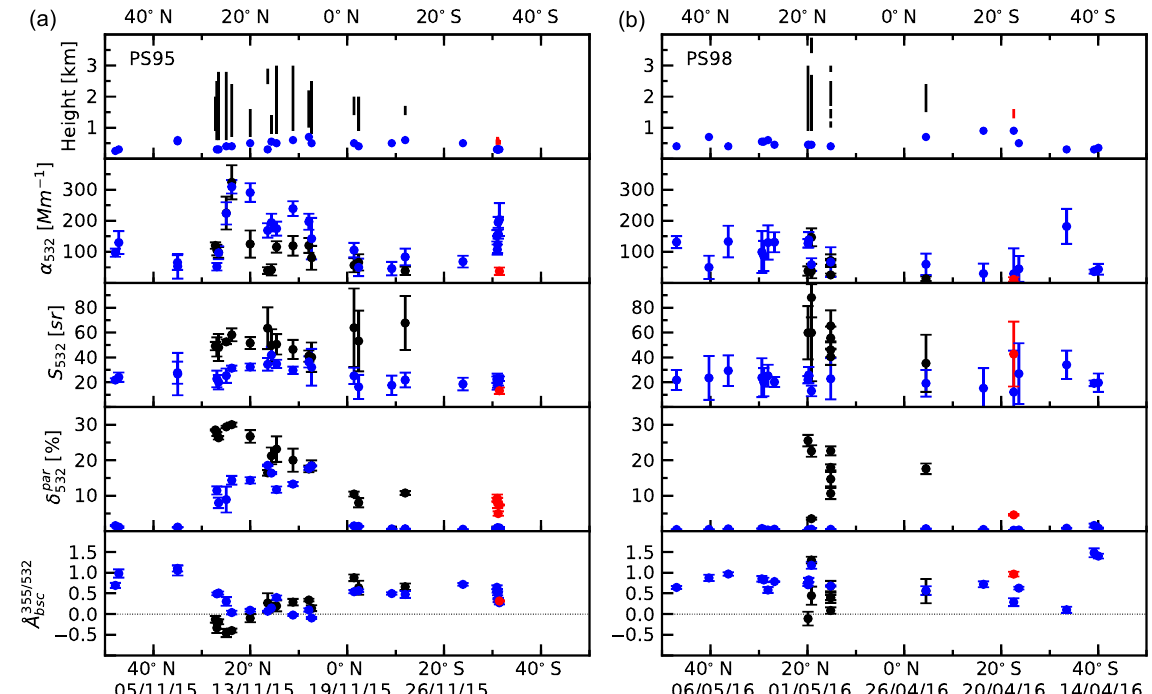
Figure 13. Mean values of extinction coefficient, lidar ratio and particle depolarisation ratio at 532nm, and the backscatter-related Ångström exponent at 355/532nm (top down) for MBL (blue), elevated aerosol layers (black), and dried marine layers (red) on PS95 (a) and PS98 (b) from north to south. Error bars indicate the standard deviation. MBL top height and extent of the elevated layers are shown in the first